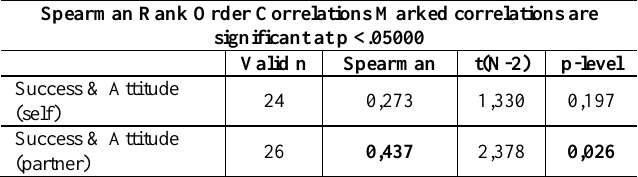
Table 4: Positive attitude and alliance success Spearman Rank Order Correlations Marked correlations are significant at p